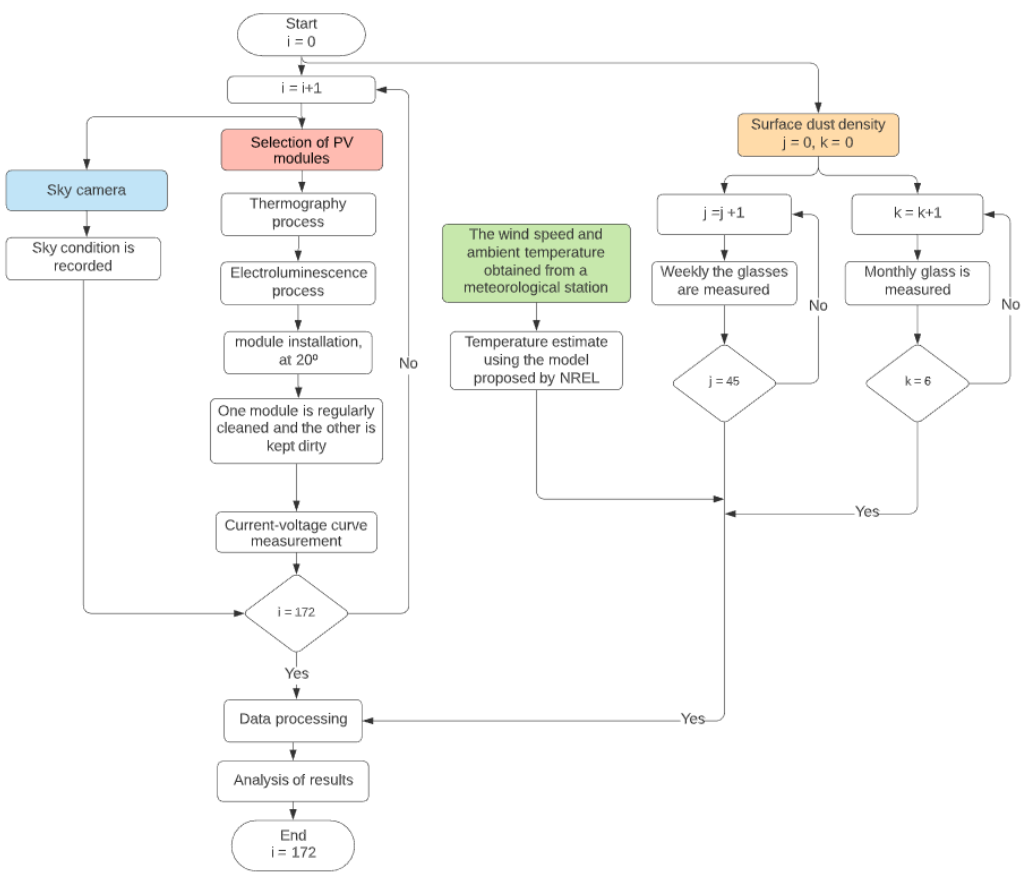
Figure 3. Flowchart illustrating the general procedure. An explanation for each box is given below.